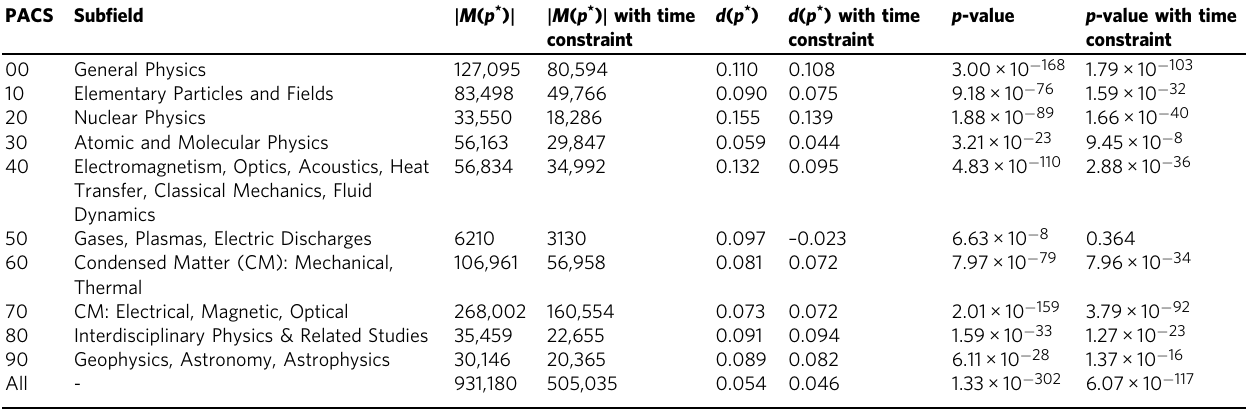
Table 2 Differences in received citations among similar pairs of publications labeled by their last-author gender.